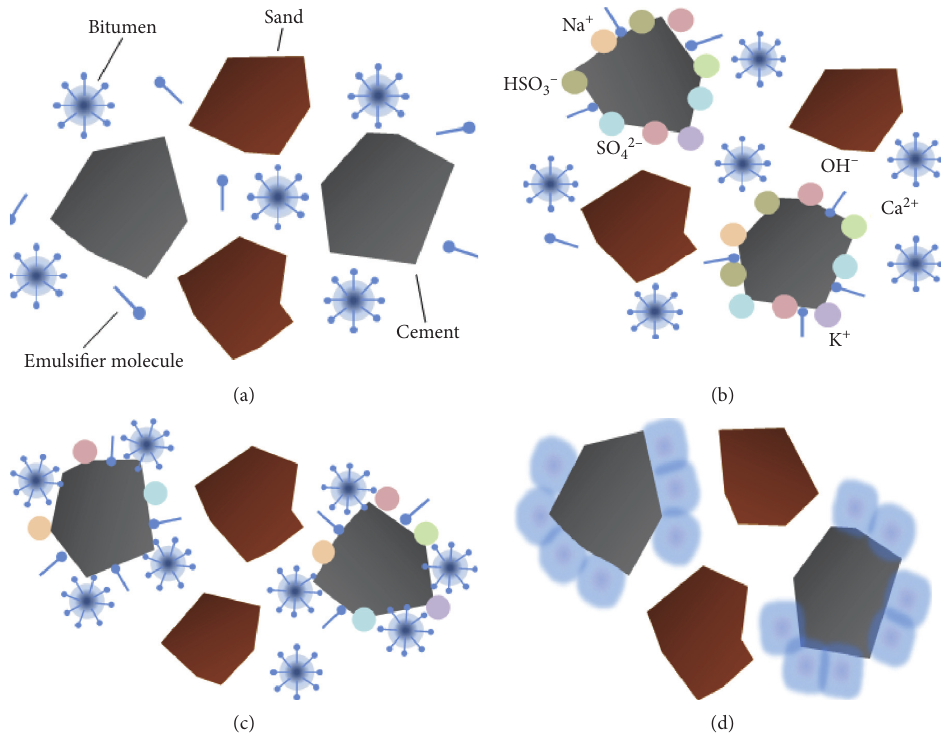
Figure 10: InfluencesofbitumenemulsiononCBEMworkability:(a)contactstage;(b)prereactionstage;(c)latestageofreaction;(d)demulsification and coagulation stage.